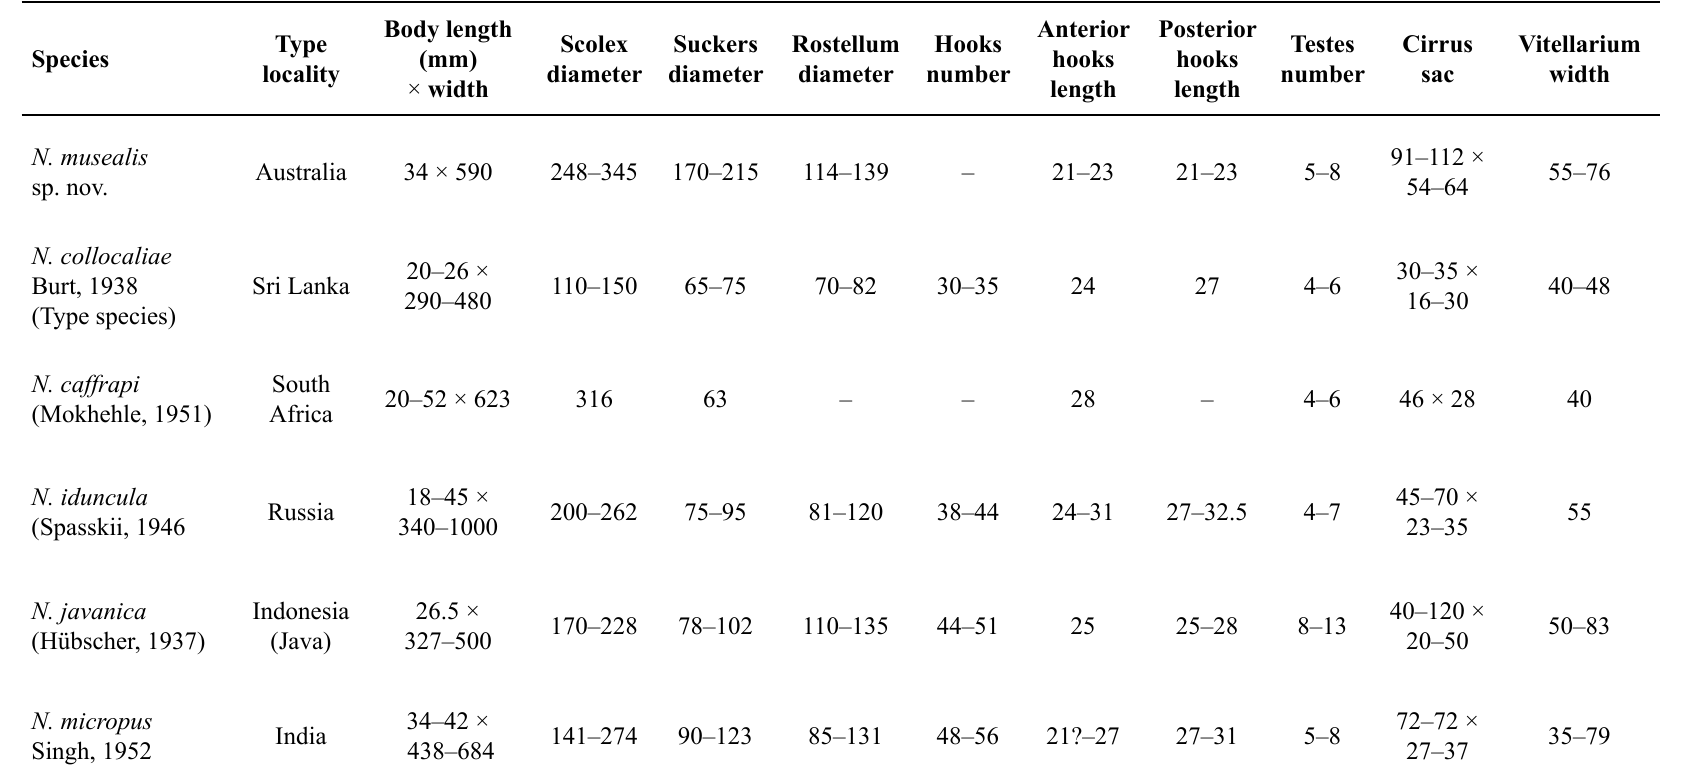
Table 5. Comparison of Notopentorchis musealis sp. nov., with the presently known species of Notopentorchis Burt, 1938 (only species with rostellar hooks of similar length in both rows are listed). Values for known species are summarized from various sources as reported in Dimitrova et al. (2017). All species are parasites of